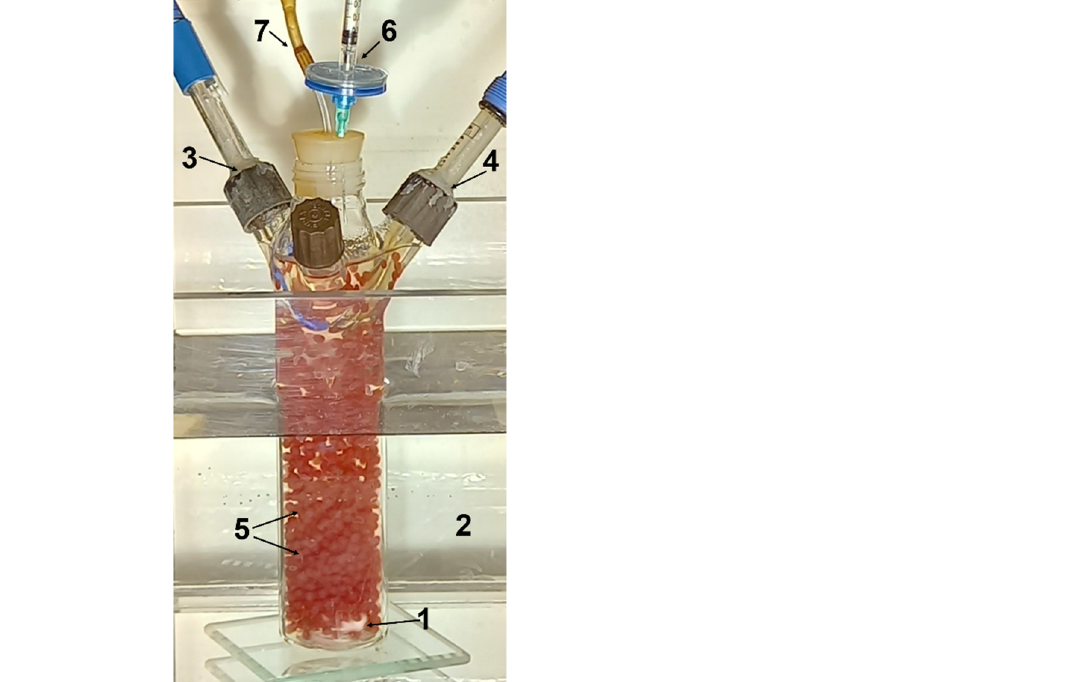
Figure 5. H 2 production by immobilized Rhodopseudomonas sp. cells in calcium alginate beads im- mersed in the cylindrical photobioreactor. Immobilized cells were washed and retested for their capacity to produce H 2 at 165 and 264 h. 4. Discussion In an anaerobic environment, photosynthetic bacteria produce H 2 . The most popular and promising photosynthetic group for biological H 2 production is PNSB [22]. PNSB use organic substrates as electron donors to produce H 2 in anaerobic environments; this pro- cess is called photofermentation. Photofermentation in PNSB is influenced by many cul- ture parameters such as the type of carbon source, the N/C ratio, and the pH [15,33]. In contrast to the low C/N ratios, which promote higher cell growth, high C/N ratios lead to higher H 2 production [6]. At low C/N ratios, the organic acids are consumed for cell de- velopment instead of producing H 2 , thus leading to a decrease in conversion efficiency. The ability to use solar energy, a wide range of light wavelengths, a variety of carbon sources, and their operation at low pressures and temperatures make photofermentation